Question: According to the figure, is the described quantity increasing or decreasing?
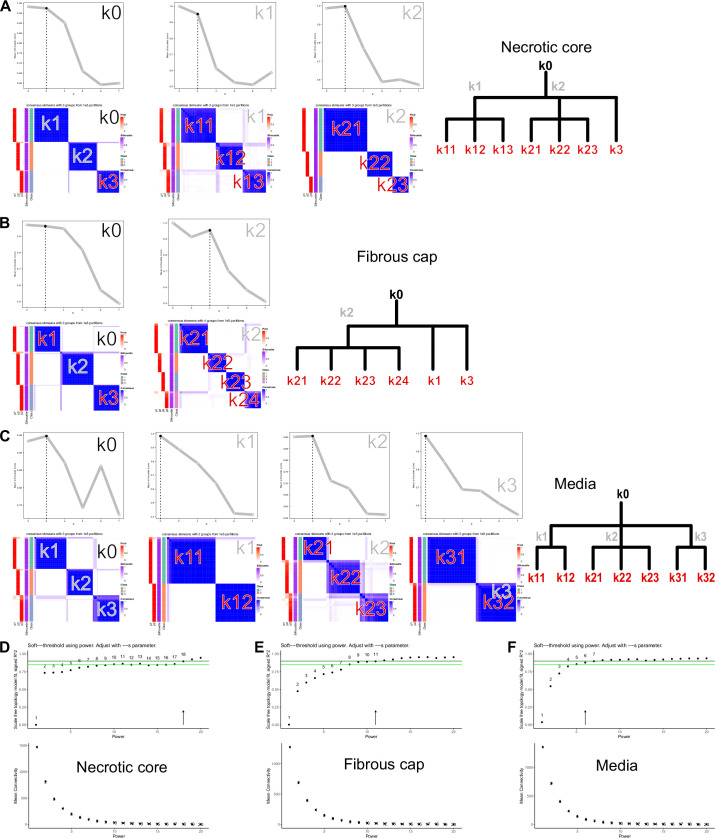
Answer: increasing